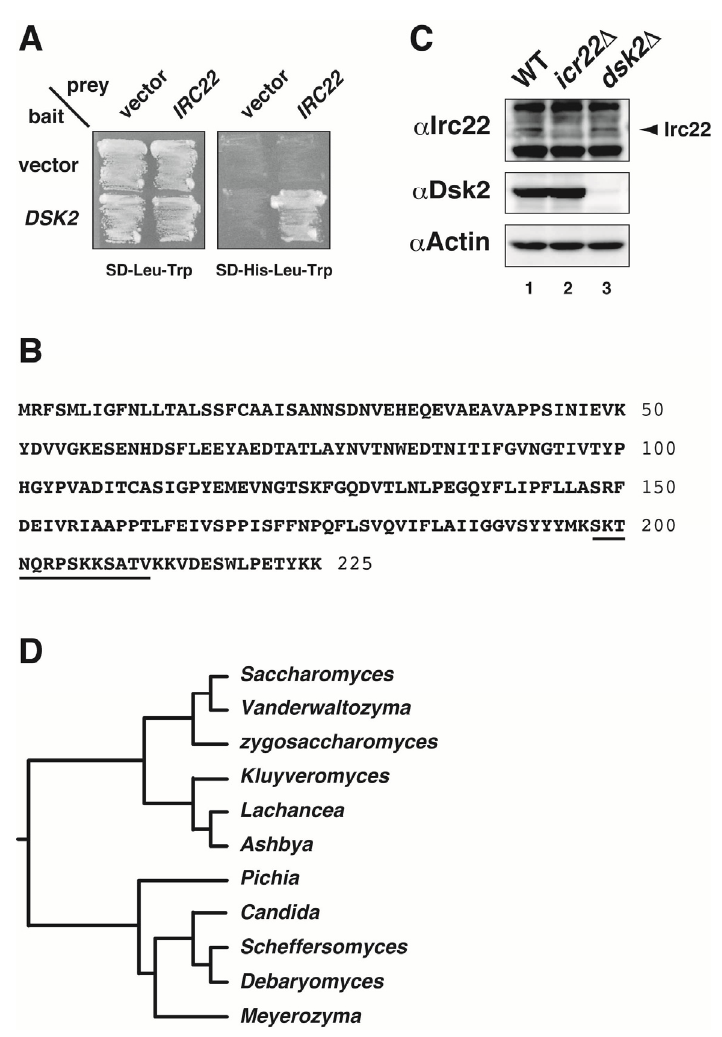
Figure 1. Identification of Irc22 in Saccharomyces cerevisiae . ( A ) Interaction of IRC22 with DSK2 in a yeast two-hybrid assay. The interaction between IRC22 and DSK2 was tested by histidine-prototrophic growth, using DSK2 as bait and IRC22 as prey. ( B ) Deduced amino acid sequence of Irc22. The deduced amino acid sequence of Irc22 is shown, and amino acid numbers are indicated at the right of the sequence. The amino acid sequence using the production of peptide antibody is underlined. ( C ) Immunoblotting of Irc22 protein. Cell extracts of wild-type strain (Lane 1), irc22 Δ ( Lane 2), or dsk2 Δ ( Lane 3) was immunoblotted with anti-Irc22 peptide antibody (top). An apparent molecular mass of Irc22 on SDS gels was estimated as ~34 kDa. Dsk2 and actin was detected as a positive (middle) and loading control (bottom), respectively. ( D ) IRC22 homolog found in ascomycetous yeasts. Homologs of IRC22/YEL001C were searched using the database of Orthologous Groups (OrthoDB) and Saccharomyces genome database (SGD). On the basis of nucleotide sequence data from both databases, IRC22 homologs were present among Saccharomycetes in